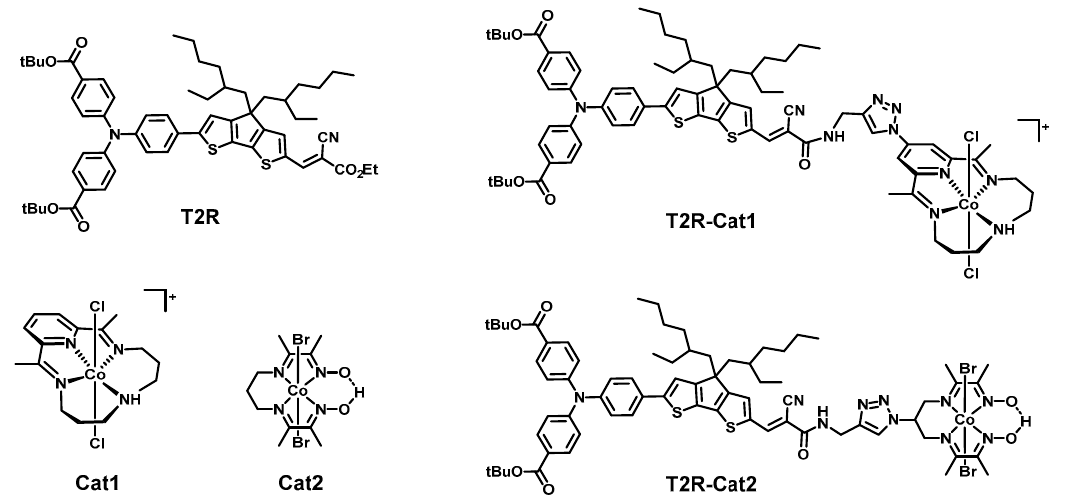
Figure 1. Structures of the dye T2R, catalysts Cat1 and Cat2, and dyads T2R-Cat1 and